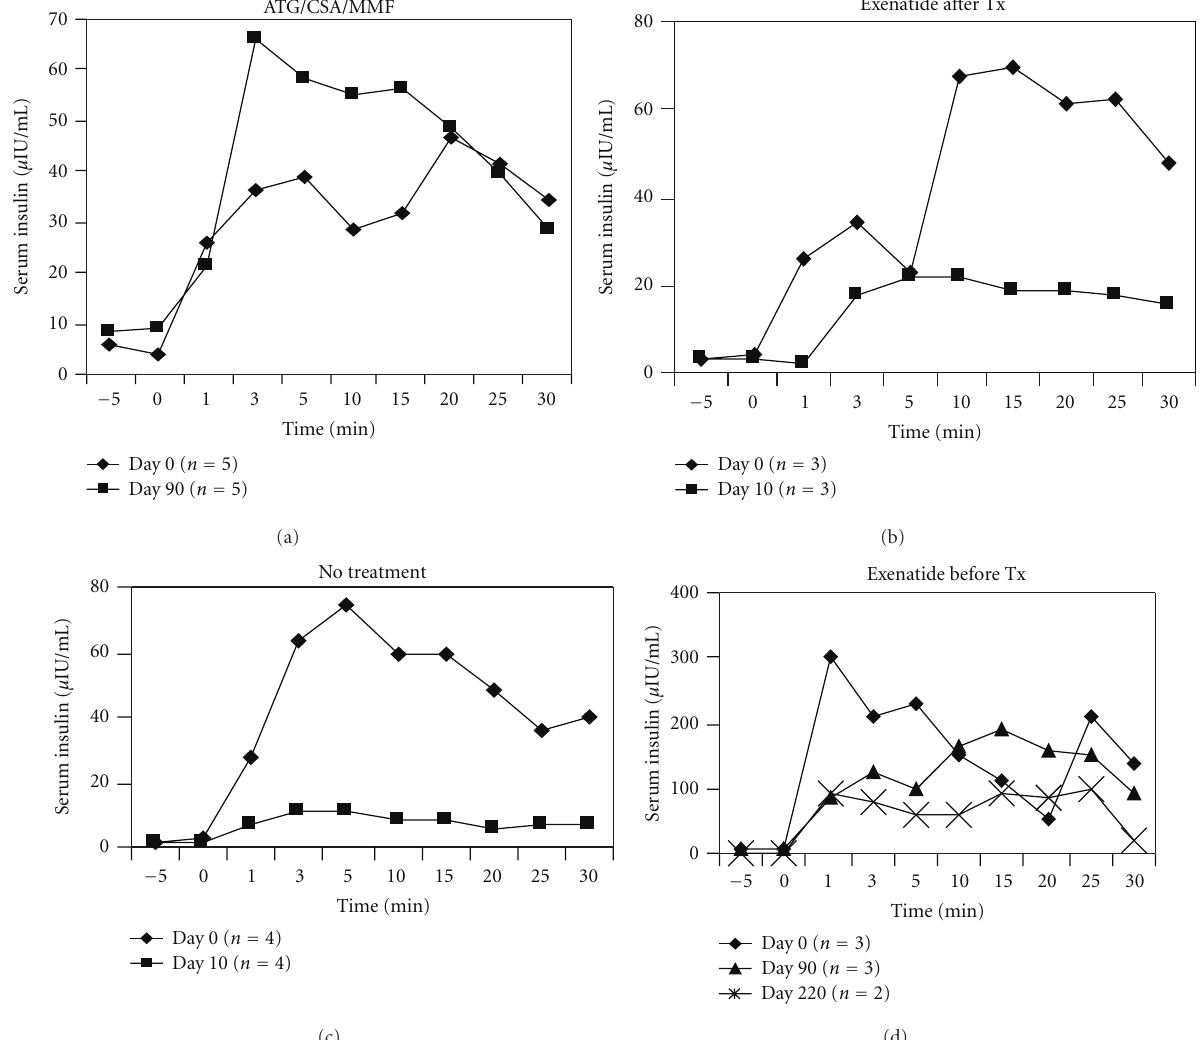
Figure 3: Serum insulin levels measured during IVGTTs as detected by ELISA for animals treated with ATG/CSA/MMF (a) or exenatide after transplant only (b), untreated (c) and pre-treated with exenatide (d).